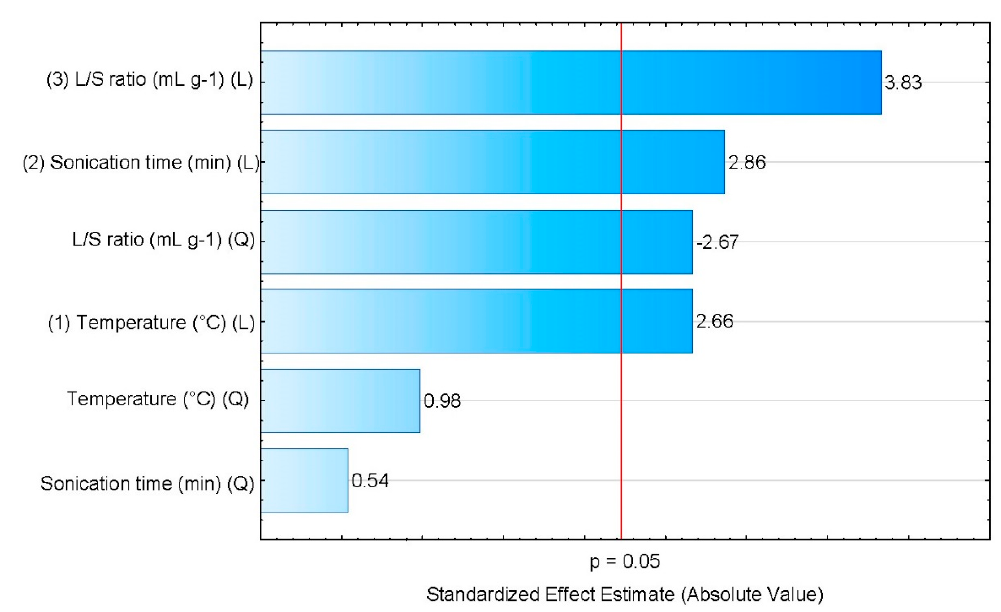
Figure 2. Pareto diagram of the experimental variables studied for the optimization of oil yield in the SCG extraction, using n-hexane as solvent.